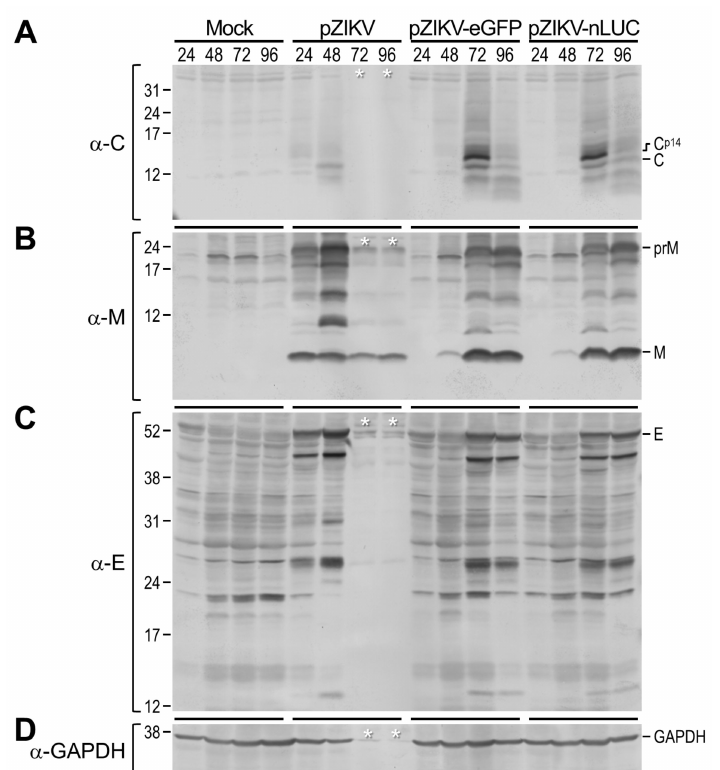
Figure 3. Profiling of viral structural protein expression. BHK-21 cells were mock-transfected or transfected with 2 µ g of the infectious RNAs transcribed from pZIKV, pZIKV-eGFP, or pZIKV-nLUC. The cells were then lysed at 24, 48, 72, or 96 h after transfection. Equal amounts of total cell lysates were resolved by SDS-PAGE, followed by immunoblotting with one of the following three rabbit antisera specific to the viral structural proteins: α -C ( A ), α -M ( B ), or α -E ( C ). In parallel, a rabbit α -GAPDH antiserum was used as a cell lysate loading-control antibody ( D ). Protein molecular size markers in kDa are indicated on the left, and major viral structural proteins and GAPDH are marked on the right. White single asterisks indicate that > 90% of cells were detached from the culture plate by virus-induced cell